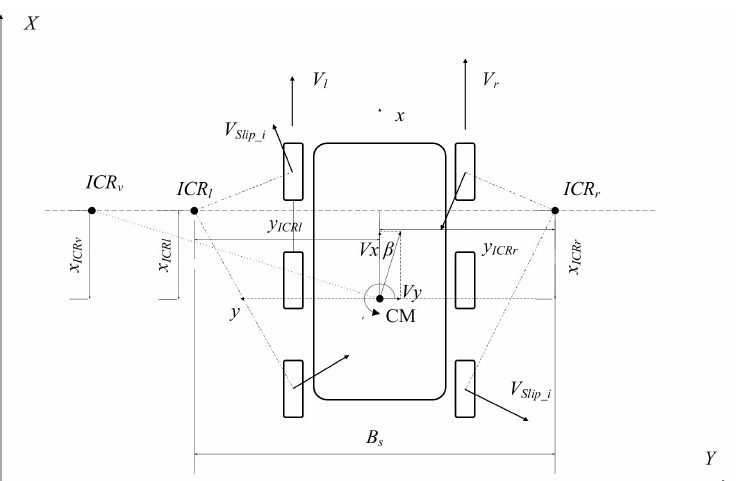
Figure 1. The ICRs of the vehicle body and the wheels on each side when a skid-steered vehicle